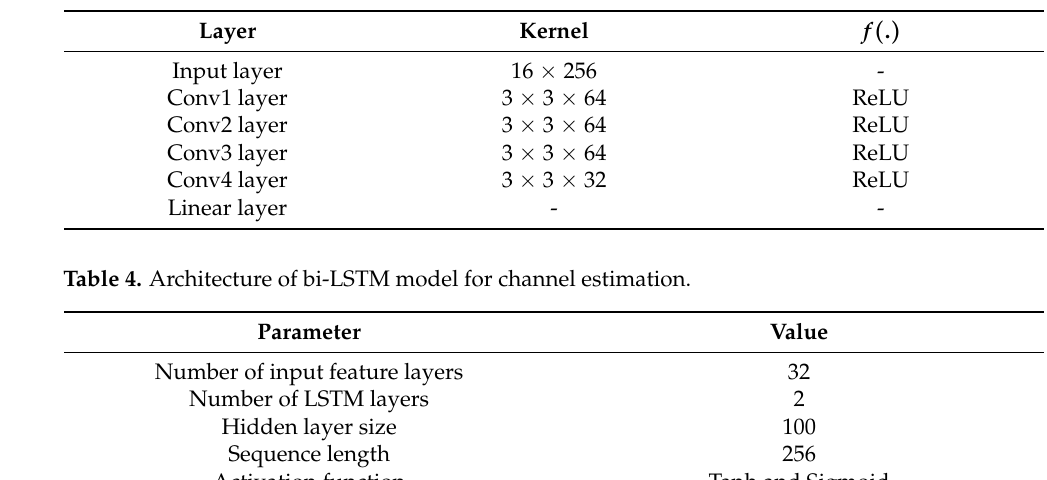
Table 3. Architecture of CNN model for channel estimation.